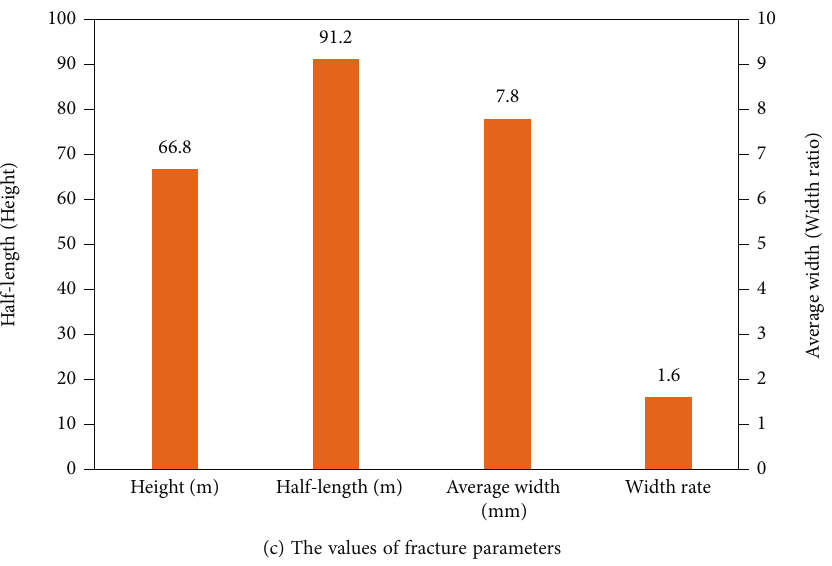
Figure 15: Distribution of the hydraulic fracture in the Taiyuan formation of well